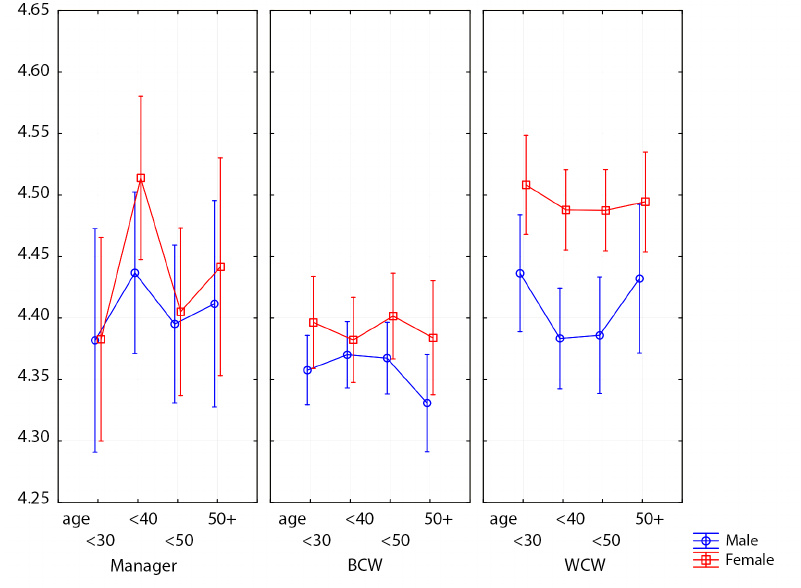
Figure 2. Tukey’s HSD test for motivation factor fair appraisal